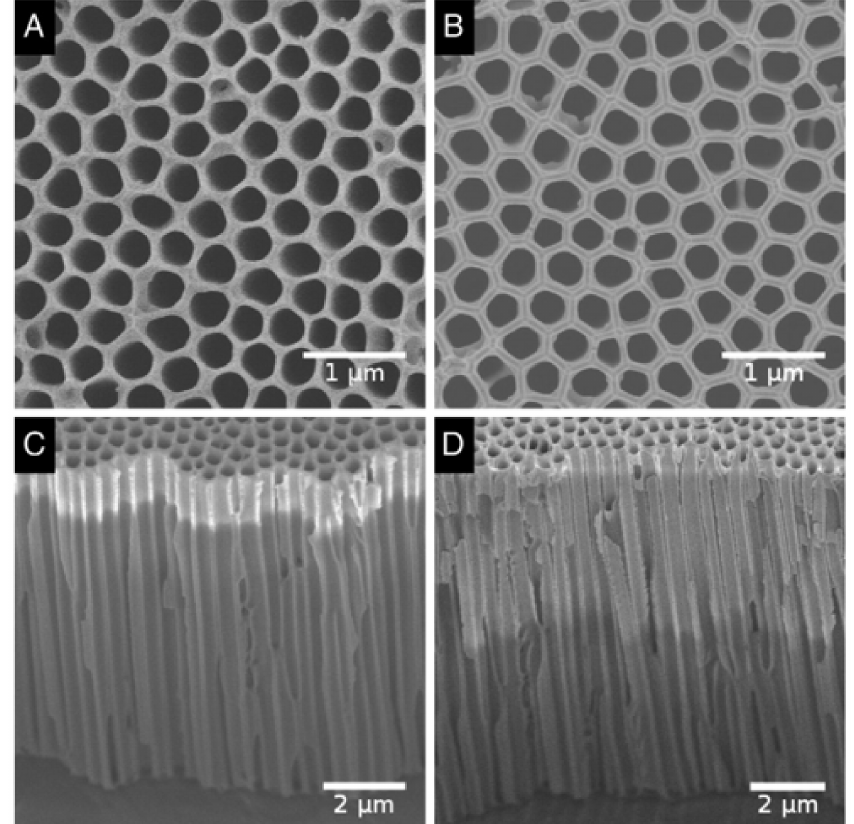
Figure 23. SEM images of the top surface of the AAO template ( A ) before Ir ALD and ( B ) after 600 cycles of Ir ALD. Cross—sectional SEM images of AAO templates with a 600 cycle Ir ALD film deposited with ( C ) 5 s Ir (acac) 3 exposures and ( D ) 10 s Ir(acac) 3 exposures. Reprinted with permission from reference [50]. Copyright 2010 Elsevier